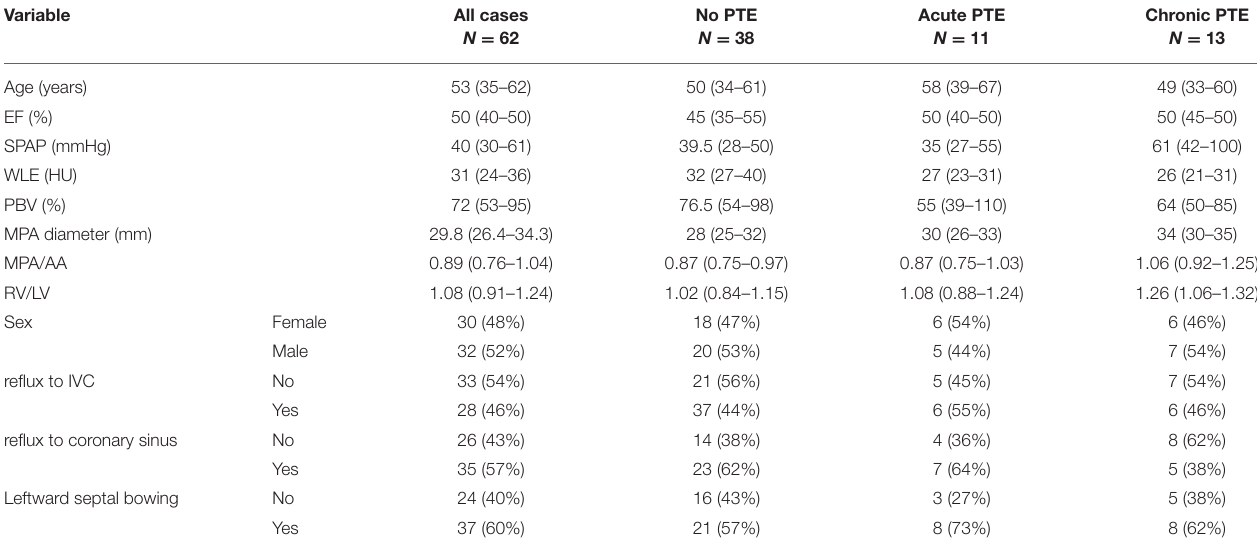
TABLE 1 | Baseline and cardiologic characteristics in total study group and subgroups according to the presence and type of PTE. Variable